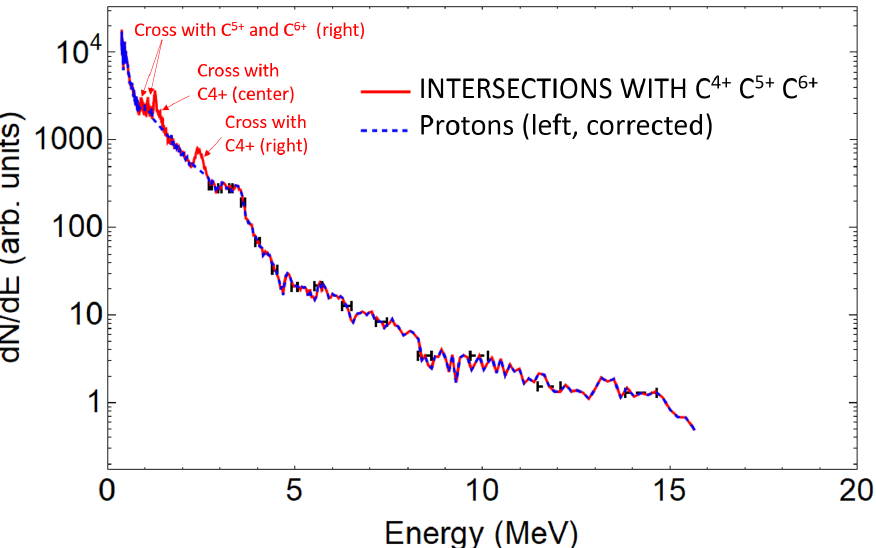
Figure 4. Left trace proton spectrum in logarithmic scale. Blue: corrected spectrum. Red: same spectrum showing the peaks subtracted, corresponding to trace crosses. Several representative error bars are plotted, picturing the estimated energy